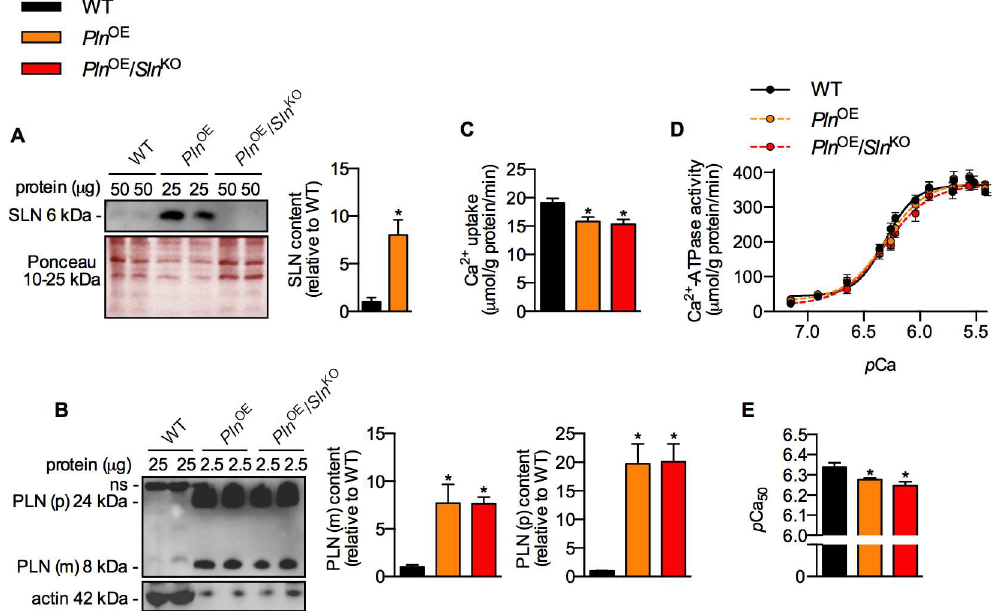
Fig 1. Sln deletion does not rescue SERCA function in Pln OE mice. (A) Western blot analysesshowing successful removal of the 8-fold upregulation in SLN protein (n = 6 per genotype). Ponceau staining